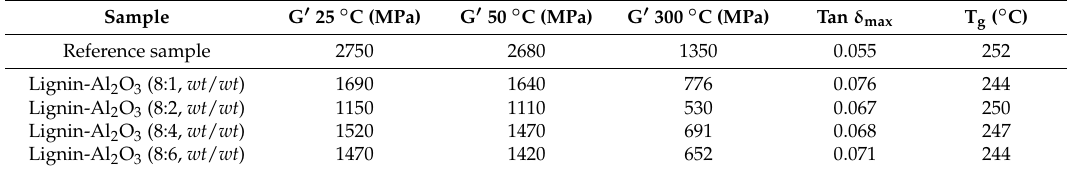
Table 6. Values of storage modules and glass transition temperature of composites obtained.